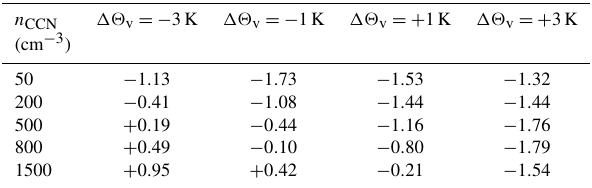
Table A7. Temperature sensitivity (in %K − 1 ) of the precipitation efficiency PE for all n CCN values.